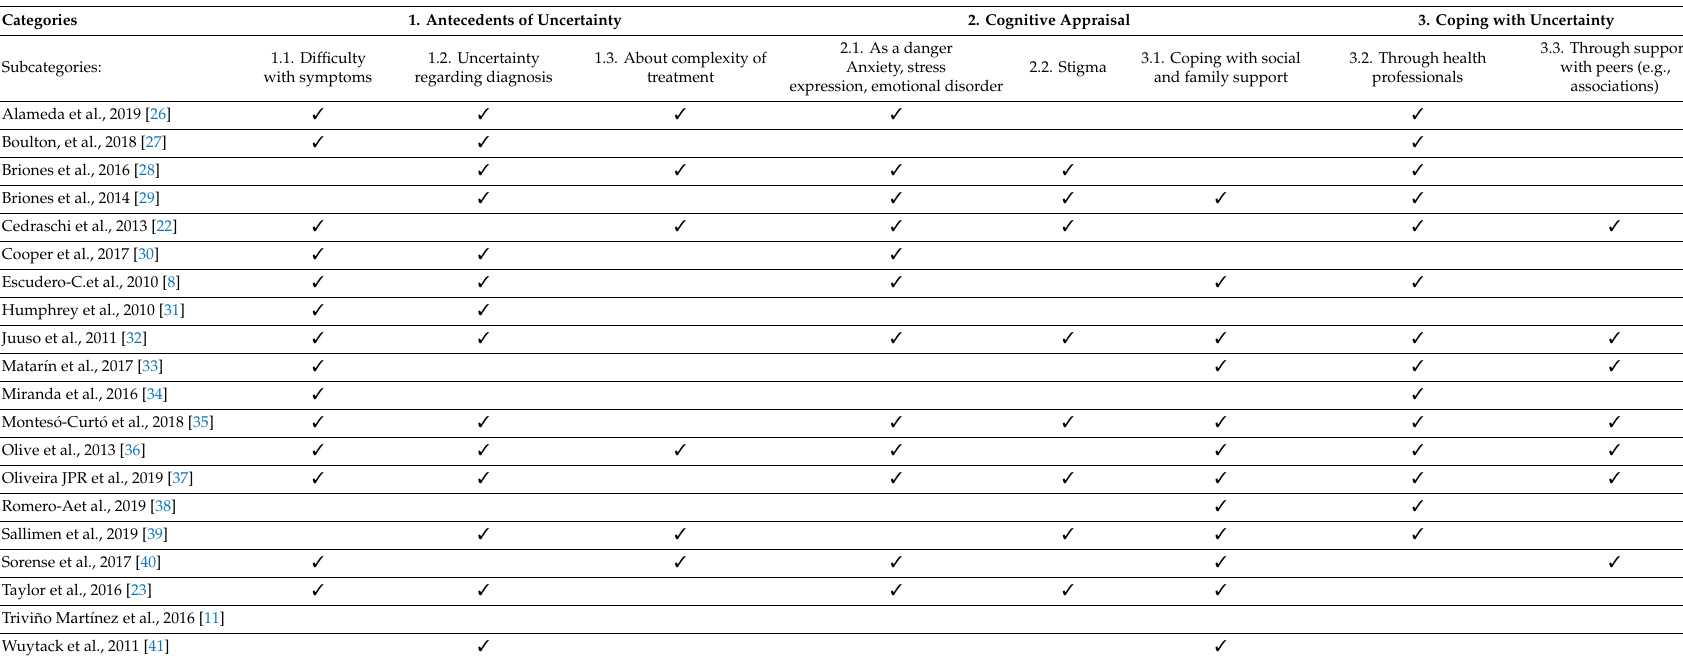
Table 2. Categories and subcategories of Mishel’s model of uncertainty in fibromyalgia syndrome identified in the experiences of patients with di ff erent qualitative